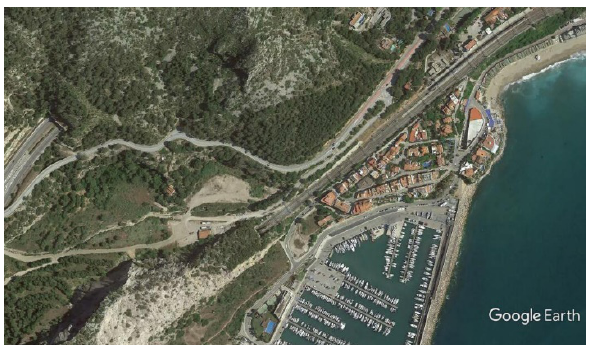
Figure 6 . Garraf town and